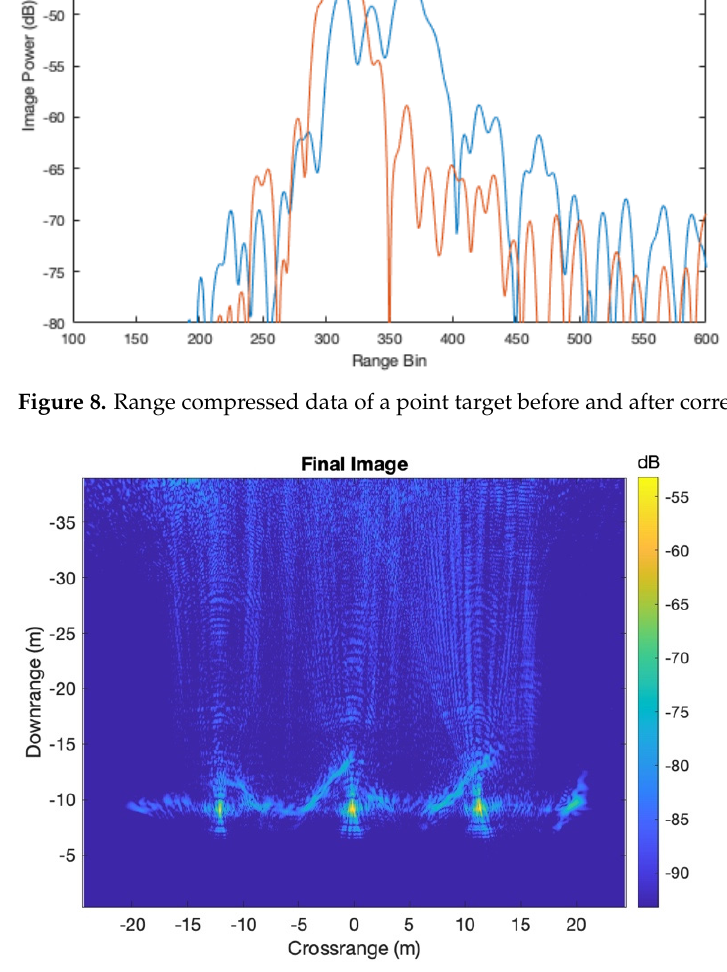
Figure 9. Radar image after correction.